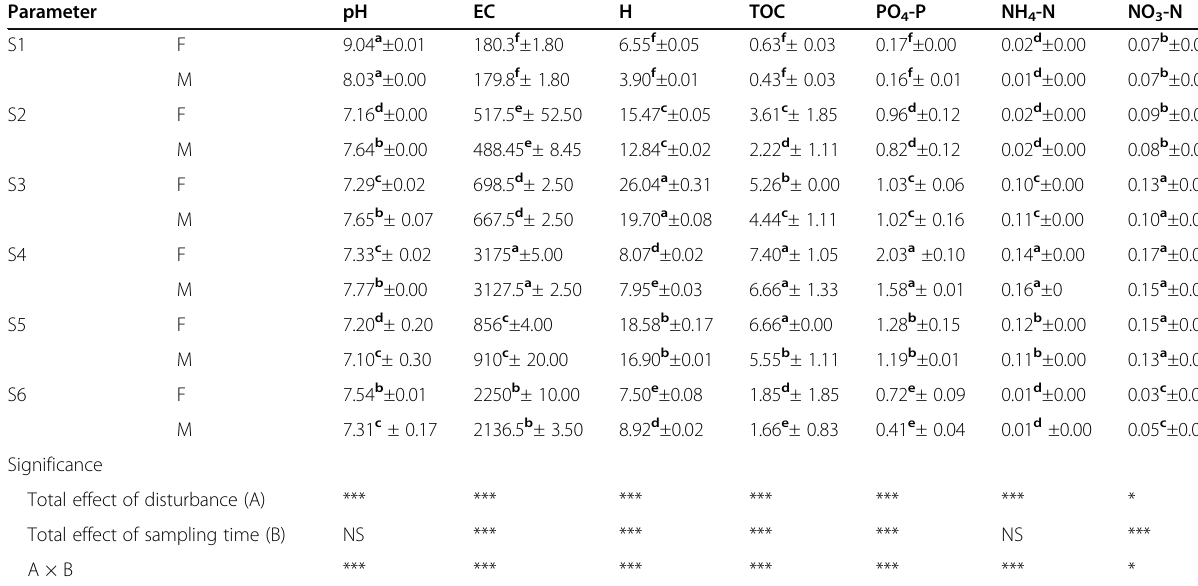
Table 2 Physicochemical properties of sampled soils Parameter